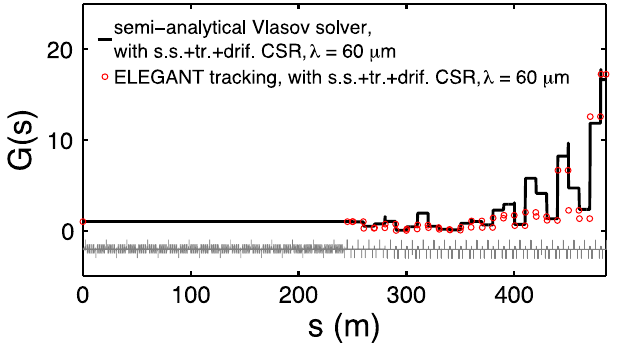
6. CSR-induced microbunching gain function G ð s Þ for the linac-arc lattice. Here the CSR models include both entrance and exit transients as well as steady-state effects. Here in ELEGANT tracking we assume 0.6% initial modulation amplitude.